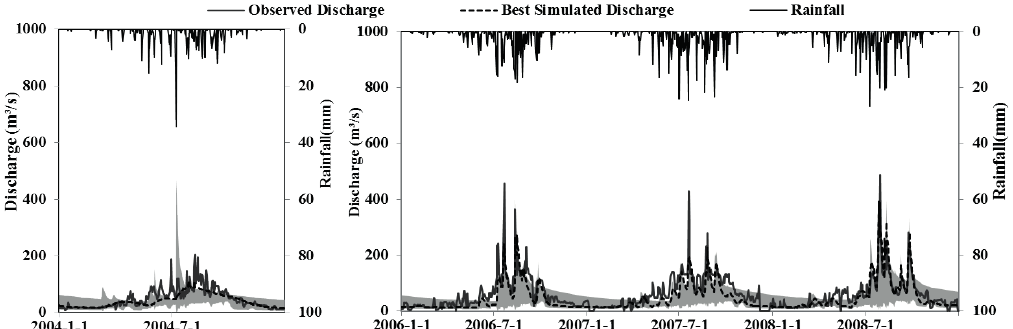
Fig. 4 Rainfall, observed and simulated discharge and 95PPU (shaded area) for calibration using river discharge data of year 2004 and validation period